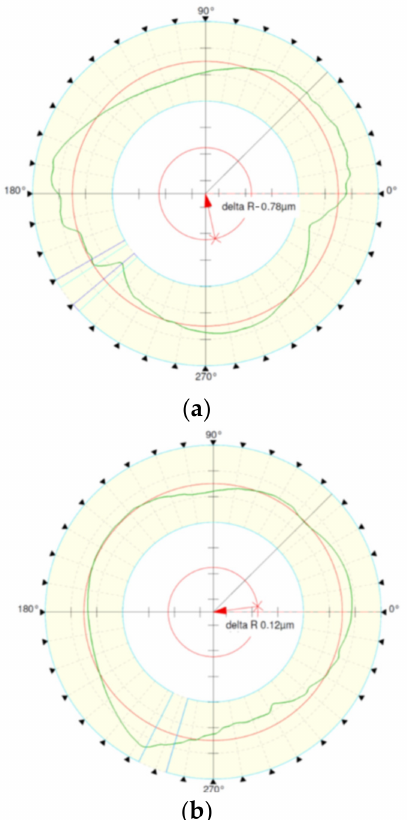
Figure 5. Roundness profiles obtained with: ( a ) grain size 30, ( b ) grain size 15.